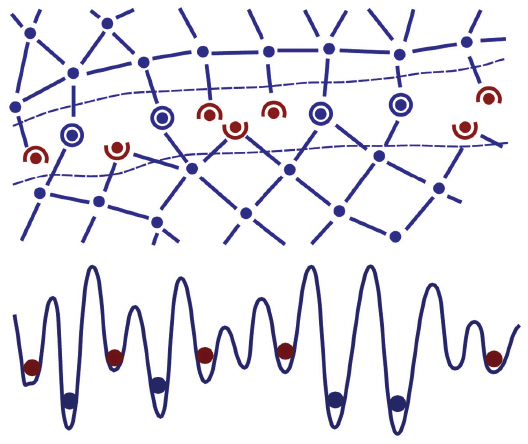
Figure 2 A fragment of sliding layer and a schematic potential relief for sites in this layer.